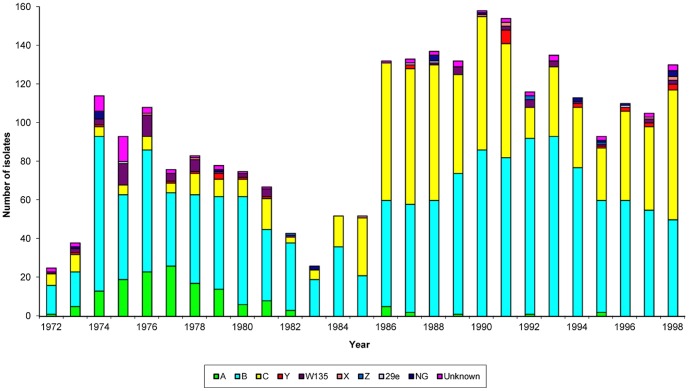
Distribution of invasive isolates associated with each serogroup, Scotland 1972-98.